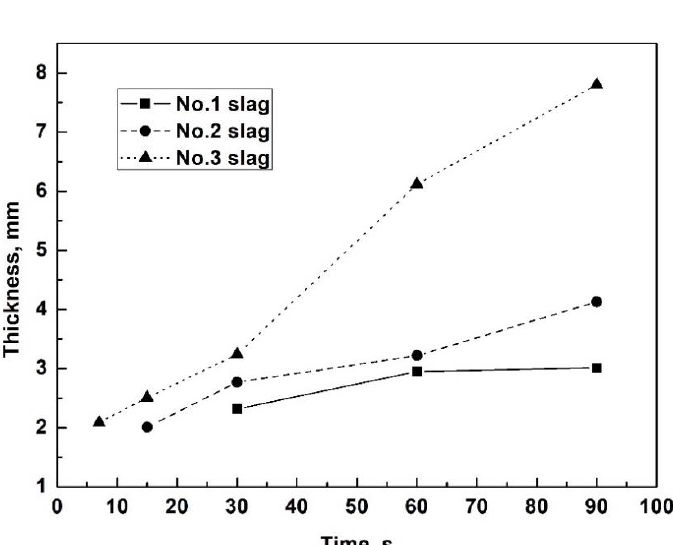
Figure 1. Average thickness of slag films solidified in slag bulk at a temperature of 1350 °C.